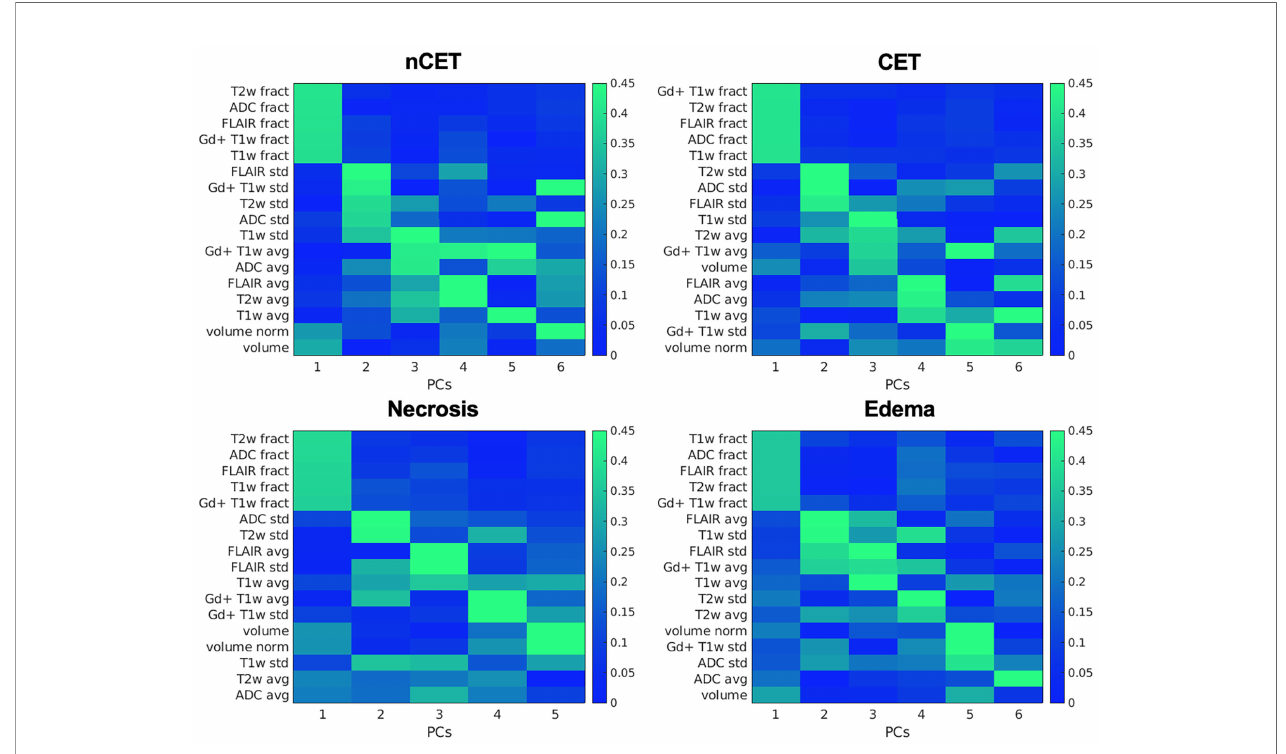
FIGURE 2 | PCA on imaging features: PC loadings are reported explaining 80% of the variance. Variables are ordered (y-axis) according to their relative loadings for each PC. Loadings are reported separately for each tissue. nCET , non-contrast-enhancing tumor; CET , contrast-enhancing tumor; PCs , principal components; fract , fractality; std , standard deviation; avg , average; norm , normalized for the total tumor volume.